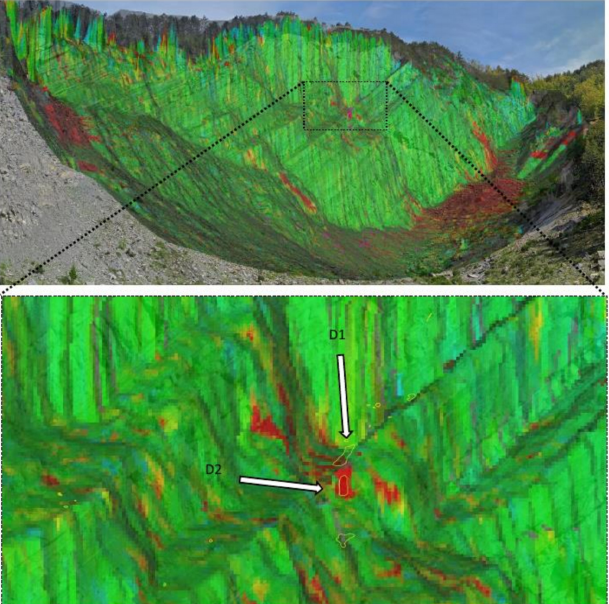
Figure 11. Central sector of the slope with correspondence between changes detected by radar measurements (green-red pixels) and GigaPan image analysis (yellow polygons); D1 and D2 polygons indicate areas that suddenly moved between 14 and 15 May